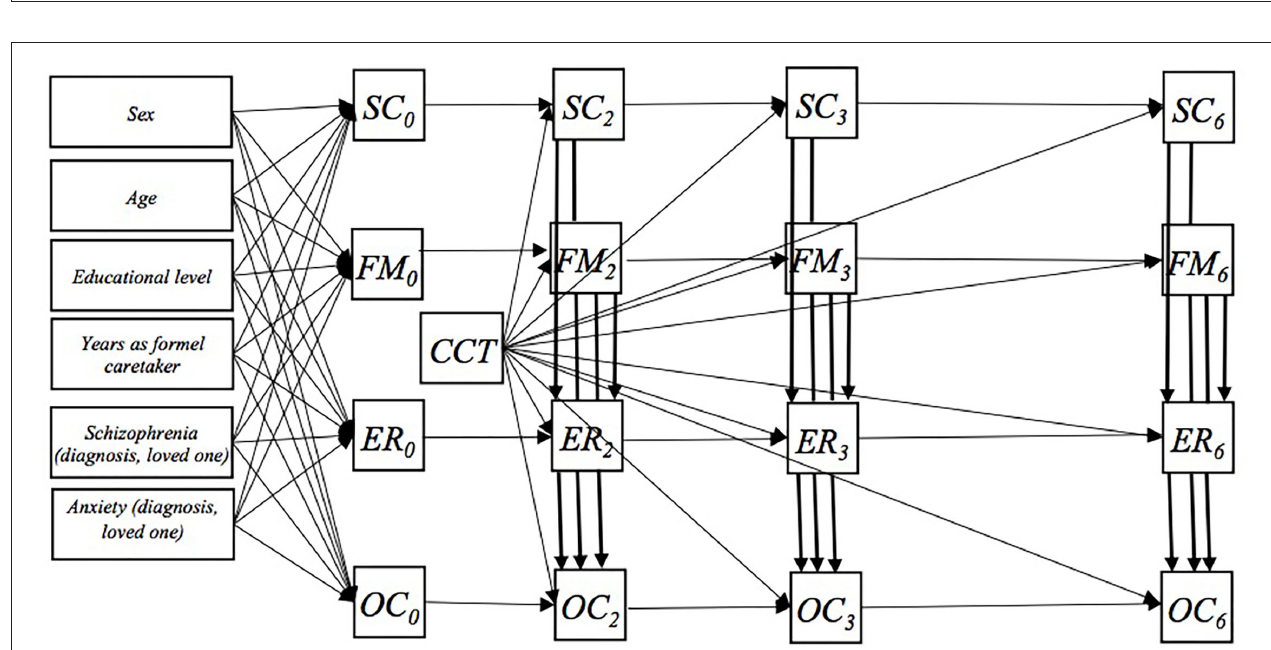
FIGURE 2 | The paths in the main model including three mediators (SC, Self-Compassion Scale-12; FFMQ-15, Five-Facet Mindfulness Questionnaire-15; and Cognitive Reappraisal; ER, The Emotion Regulation Questionnaire. Not shown in the figure: At baseline, residual covariance between all mediators and outcome, OC. At each follow-up time, residual covariance between all mediators. For each mediator and the outcome residual covariance over time.